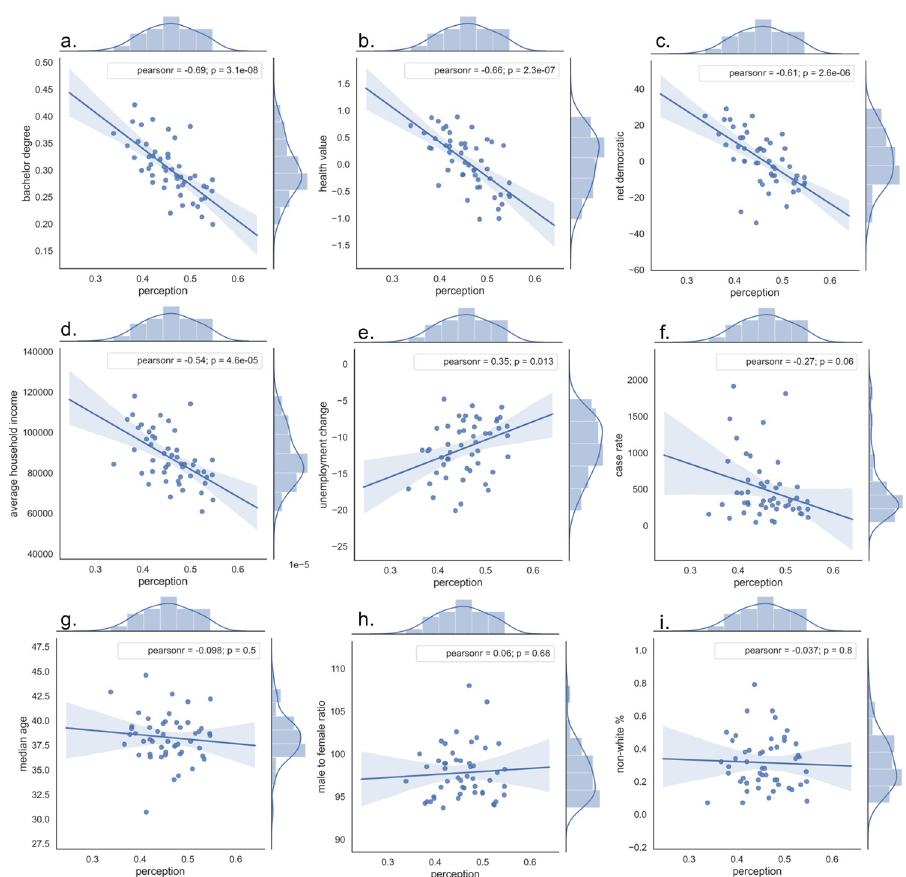
Fig 6. Correlation analysis with selected factors. a. Correlation with bachelor degree % (R = -0.69, p-value < 0.001). b. Correlation with health value (R = -0.66, p-value < 0.001). c. Correlation with net democratic (R = -0.61, p- value < 0.001). d. Correlation with average household income (R = -0.54, p-value < 0.001). e. Correlation with unemployment change rate (R = 0.35, p-value = 0.013). f. Correlation with case rate (R = -0.27, p-value = 0.060). g. Correlation with median age (R = -0.098, p-value = 0.497). h. Correlation with male to femal ratio (R = -0.06, p- value = 0.677). i. Correlation with non-white % (R = -0.037, p-value =